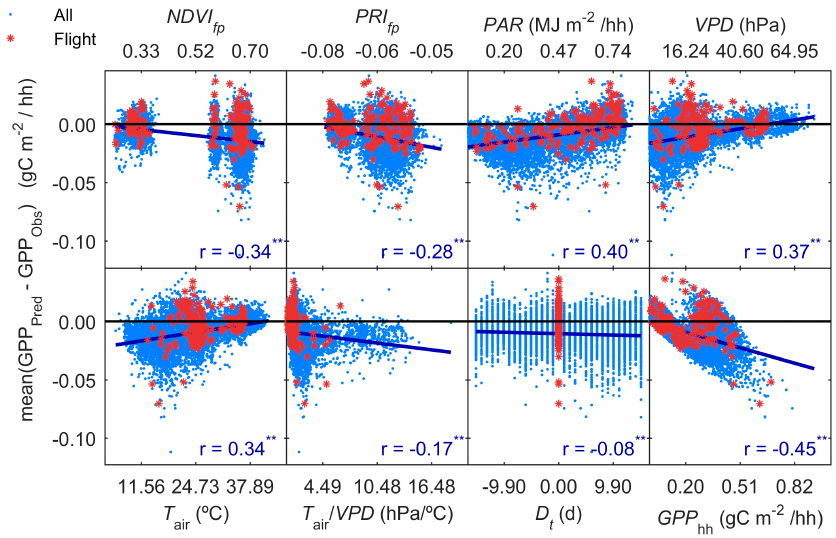
Figure 7. Mean error of MOD2–MOD4 vs. different variables. The adjusted linear model and Pearson correlation coefficient of the whole dataset are shown with the respective significance degree (** p < 0.05; * p < 0.10). In addition, data corresponding of the date of each flight are flagged.